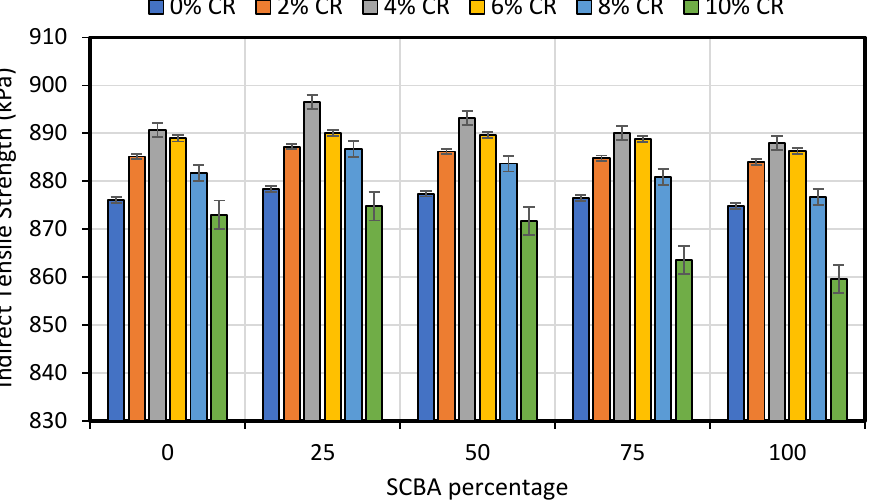
Figure 7. Effect of additions of CR and SCBA on split tensile strength of asphalt concrete.